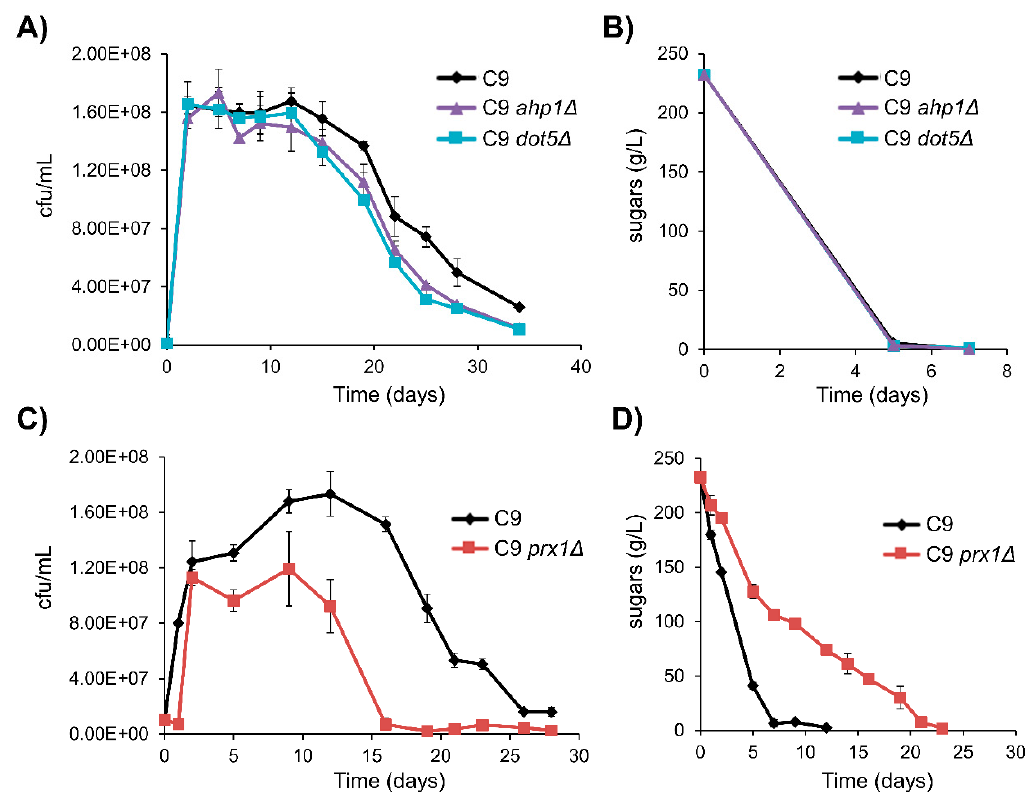
Figure 8. Mitochondrial peroxiredoxin plays a relevant role in fermentation. C9 and the derived mutants were grown in red grape juice. ( A ) CFUs of the C9 ahp1 Δ and C9 dot5 Δ mutants. ( B ) The reducing sugar consumption of this fermentation. ( C ) CFUs of the C9 prx1 Δ and C9 reference strain. ( D ) The reducing sugar consumption of this fermentation. Experiments were carried out in triplicate. The mean and standard deviation are shown.